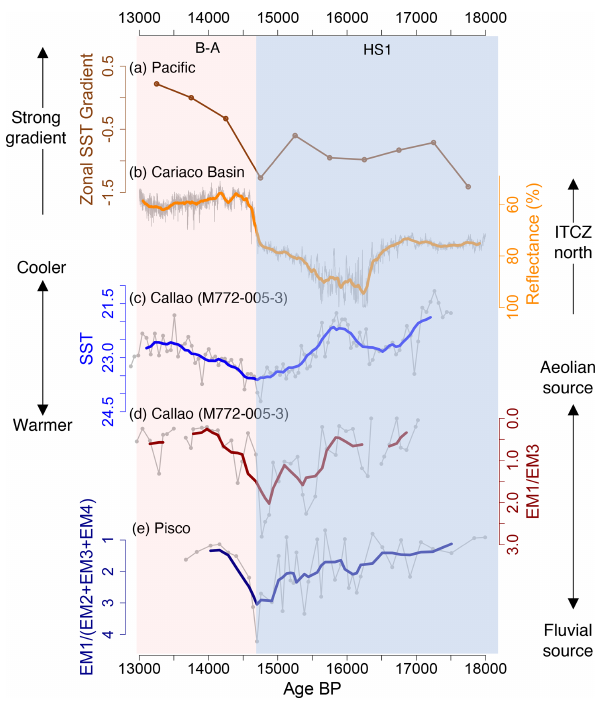
Figure 8. (a) Zonal SST gradient anomaly during the last deglacia- tion, calculated here as the difference between western and eastern Pacific averages (Koutavas and Joanides, 2012). (b) Reflectance (%) from the Cariaco Basin as a proxy for the latitudinal displacement of the ITCZ (Deplazes et al., 2013). (c) Alkenone-derived near-surface temperature from the M77/2-005-3 core in Callao (Salvatteci et al., 2019). (d) EM1 / EM2 ratio (reversal scale) as a proxy for fluvial and eolian sources in Callao (this study). (e) EM1 / (EM2 + EM3 + EM4) ratio (reversal scale) as a proxy for fluvial and eolian sources in Pisco (this